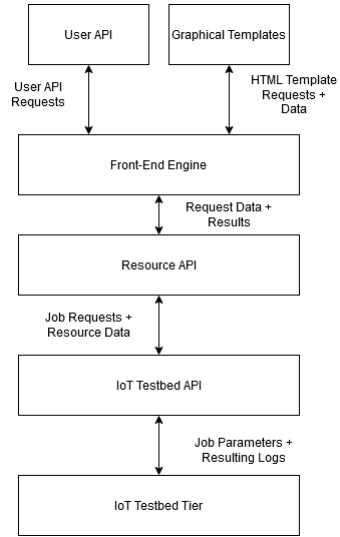
Figure 4. System UML Block Diagram.